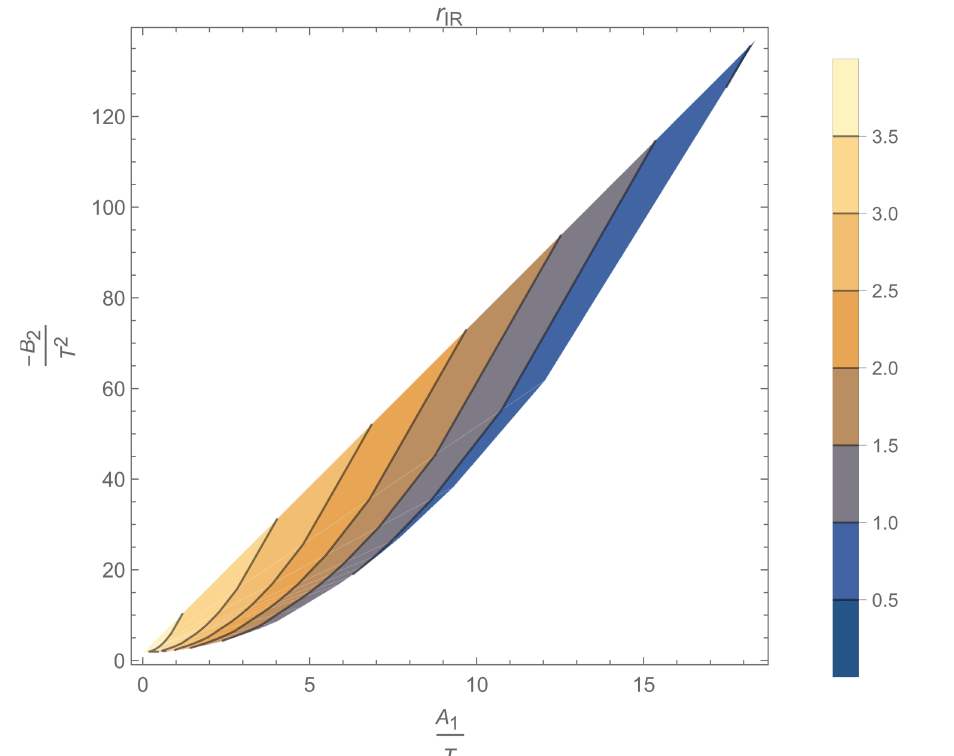
Figure 18. A contour plot of r IR with the deformation parameters for the supergravity